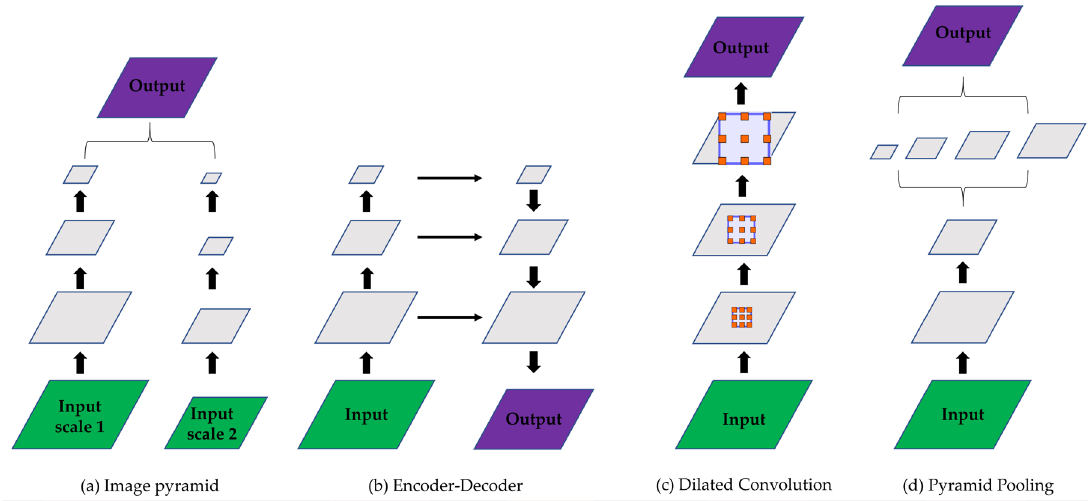
Figure 2 . Four types of network architectures for multiscale contexts. Figure 2. Four types of network architectures for multiscale contexts.